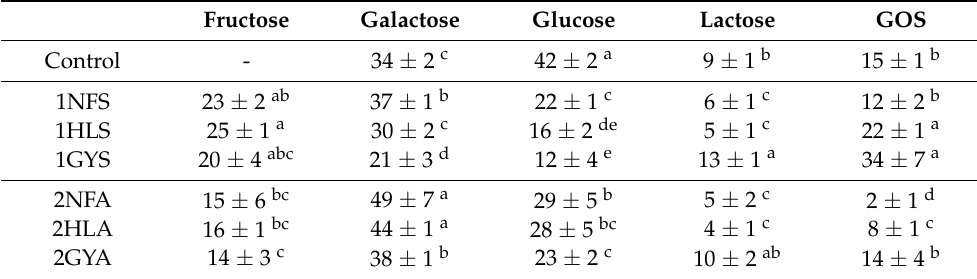
Table 1. Glucose-galactose syrups’ sugar compositions at solids